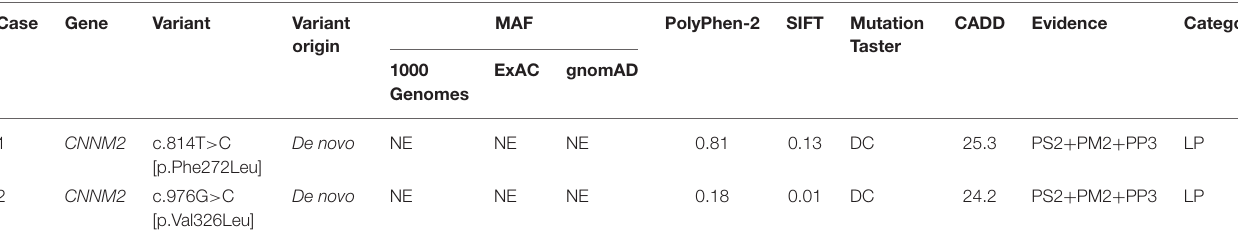
TABLE 1 | Analysis of pathogenicity of the variants in CNNM2 .